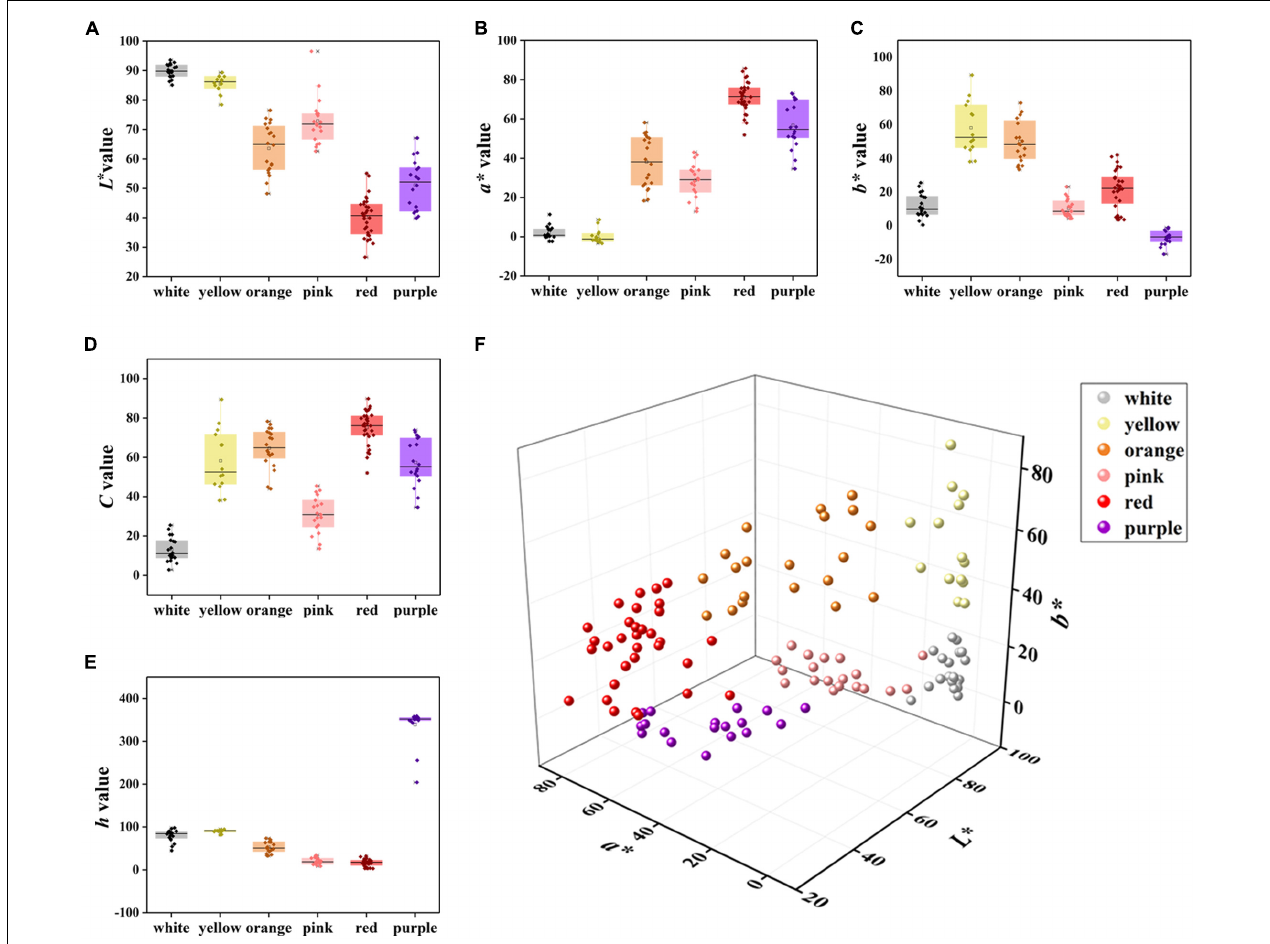
FIGURE 2 | Comparison of L* , a* , b* , C , and h values of six color groups. (A) L* value, (B) a* value, (C) b* value, (D) C value, (E) h value, and (F) flower color distribution of 123 accessions based on L* , a* , and b* values.